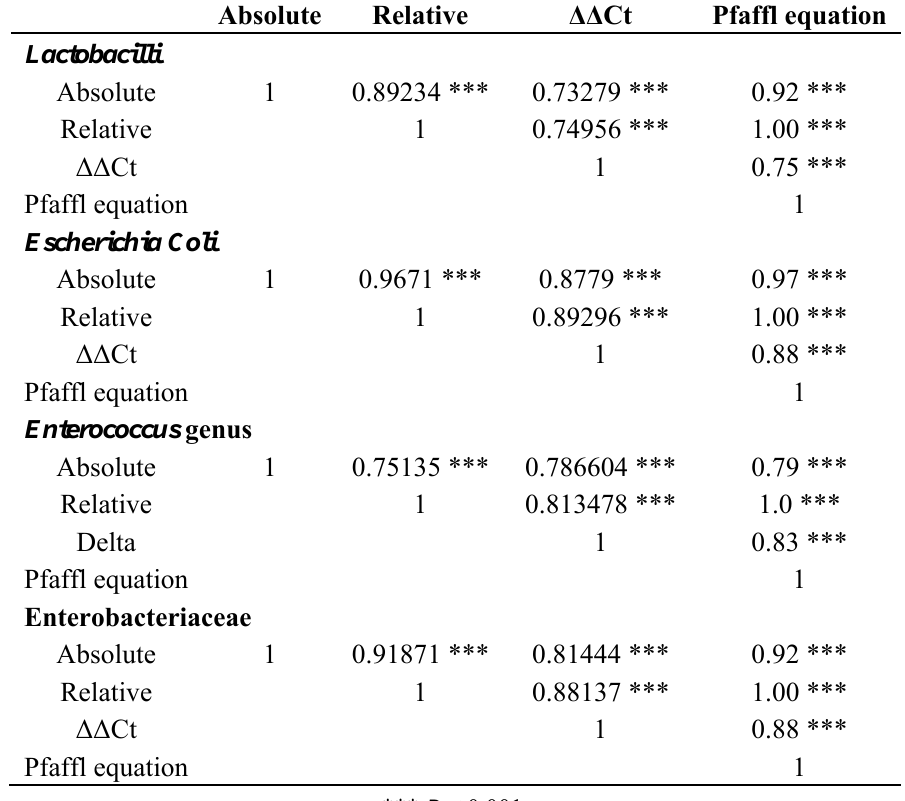
Table 2. Correlation coefficients between three methods in different bacteria